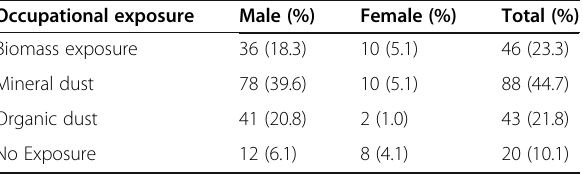
Table 10 Distribution of occupational exposure with respect to